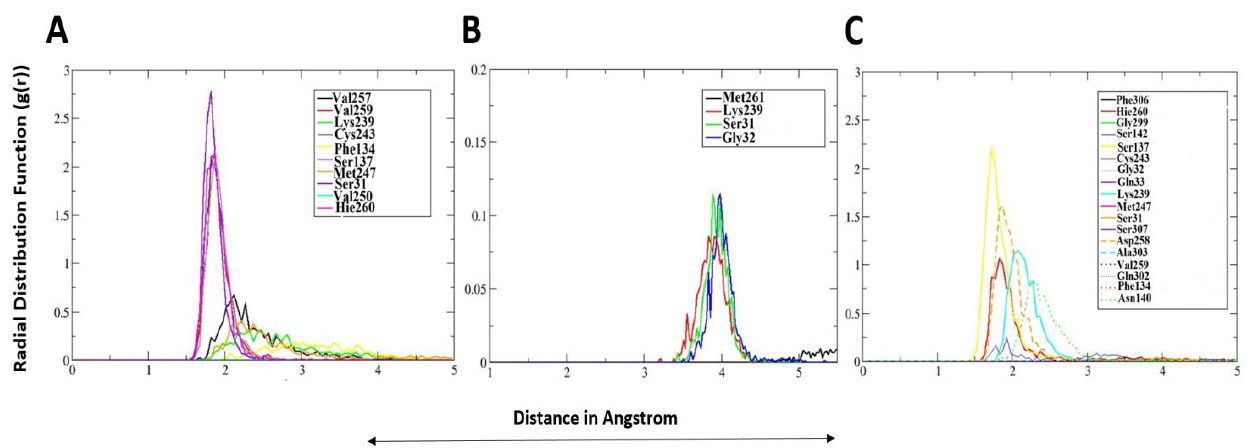
Figure 4. Radial distribution analysis of hydrogen bonds/van der Waals formed between the compounds and enzyme active site residues. ( A ) Control , ( B ) Top-1 , and ( C ) Top-2 . Only key interactions are plotted in radial distribution analysis.